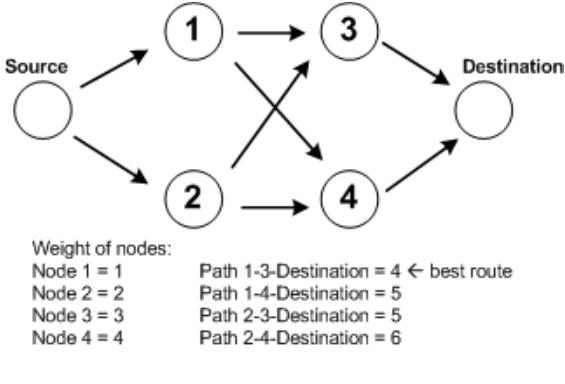
Figure 6. An example of Least Total-Route Temperature